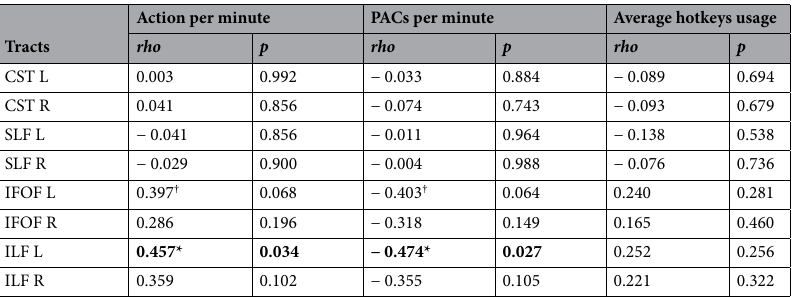
Table 2. Correlation results between FA along the tracts and StarCraft II performance indicators. The results presented in the table are without the FDR correction. L left, R right, CST corticospinal tract, SLF superior longitudinal fasciculus, ILF inferior longitudinal fasciculus, IFOF inferior fronto-occipital fasciculus, PACs perception action cycles. * p < 0.05; † p < 0.10. Significant results are in bold.